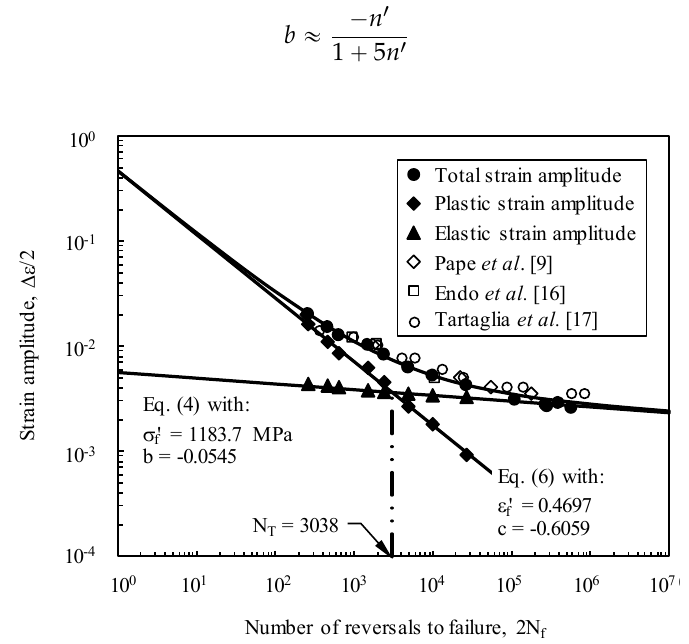
Figure 10. Total strain-life, fatigue strength-life, and fatigue ductility-life curves [5]. Reprinted from Theoretical and Applied Fracture Mechanics , Vol. 58, Branco, R.; Costa, J.D.; Antunes, F.V. Low-cycle fatigue behavior of 34CrNiMo6 high strength steel, 28–34, Copyright (2012), with permission from Elsevier.